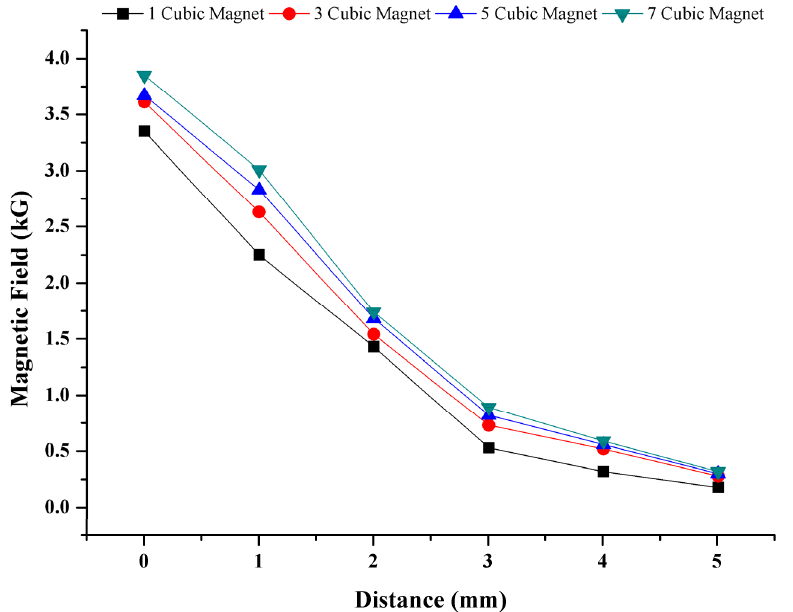
Figure 3. Magnetic field dependency on distance and number of magnets. Magnetic field on cell– magnetic bead conjugate is based on number of magnets and the distance from magnets.